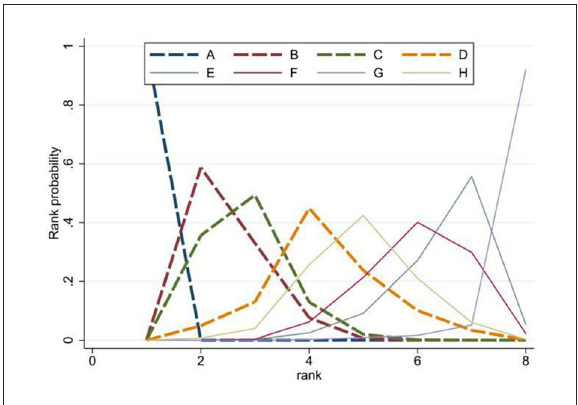
FIGURE4 Rank probability of the mortality of different